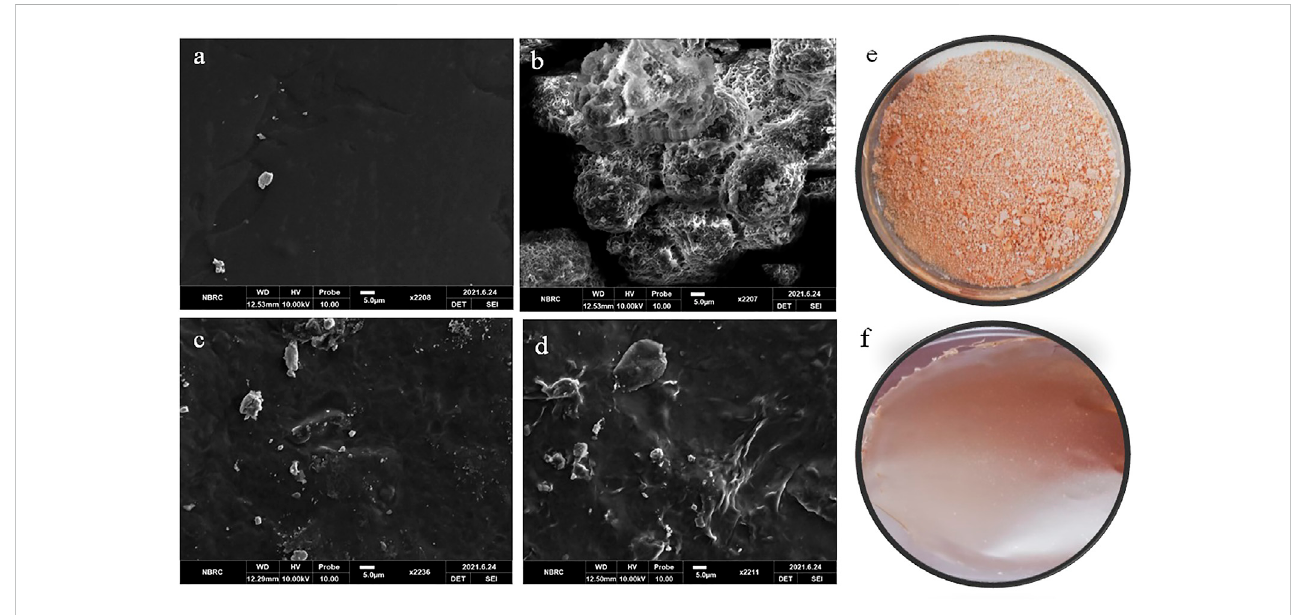
FIGURE 5 SEM images of (A) blank fi lm (B0), (B) pure Betula utilis extract, (C) B4, and (D) B6. Optical image (E) pure Betula utilis extract and (F) B6.